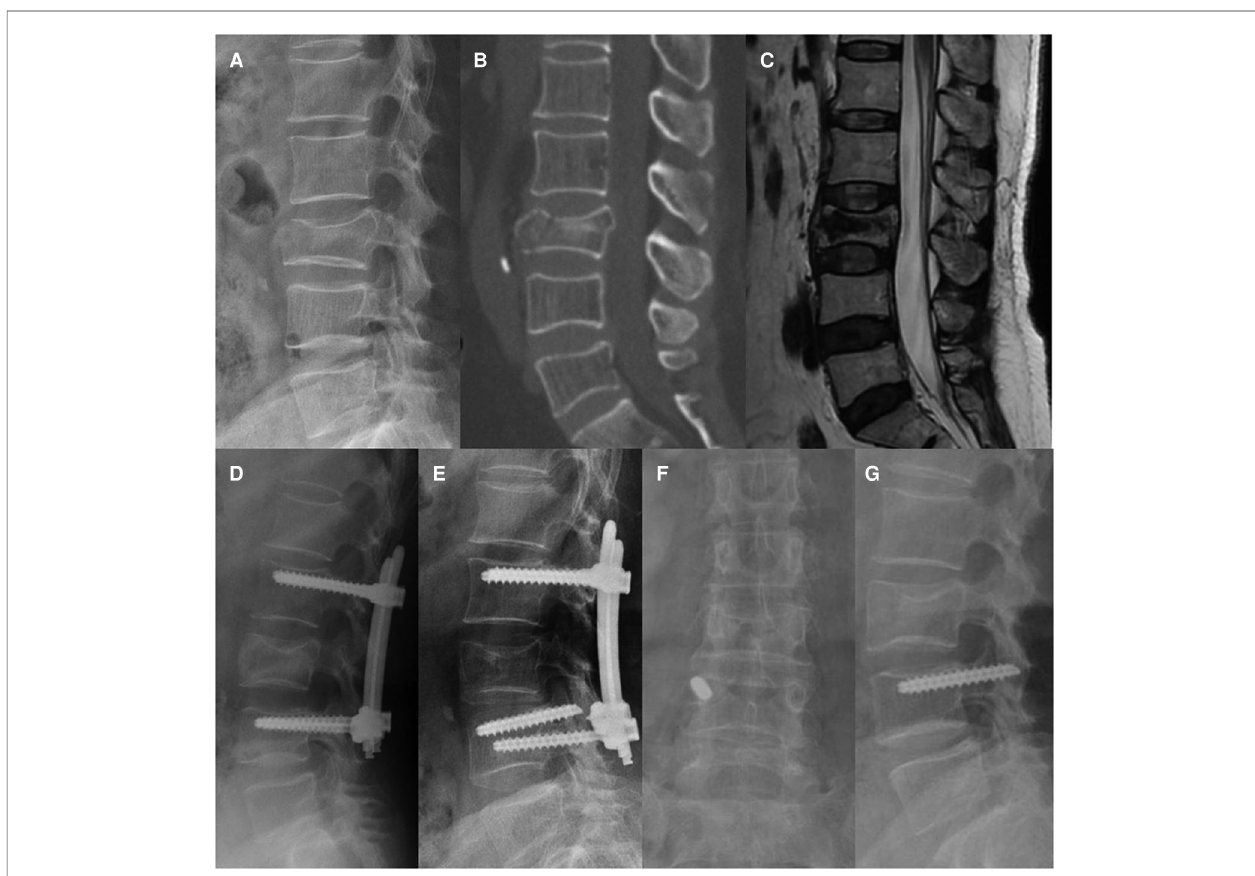
FIGURE 4 | Non-fusion fi xation using percutaneous pedicle screws for L3 fracture (type A4). A 68-year-old man from group B presented in 2016 with severe lower back pain without neurological de fi cit after a fall. ( A – C ) Preoperative lateral radiography, sagittal computed tomography, and T-2 weighted magnetic resonance imaging were taken 6 h after the fall. ( D ) Lateral radiography was taken at the 3-month follow-up. ( E ) At the 21-month follow-up, screw breakage was found without any symptoms. Implant removal surgery was subsequently performed, the broken screw could not be removed. ( F , G ) At the 56-month follow-up, anteroposterior and lateral radiographs show that the L3 vertebral body height and kyphotic angle were almost maintained, and the broken screw was still in the right pedicle of